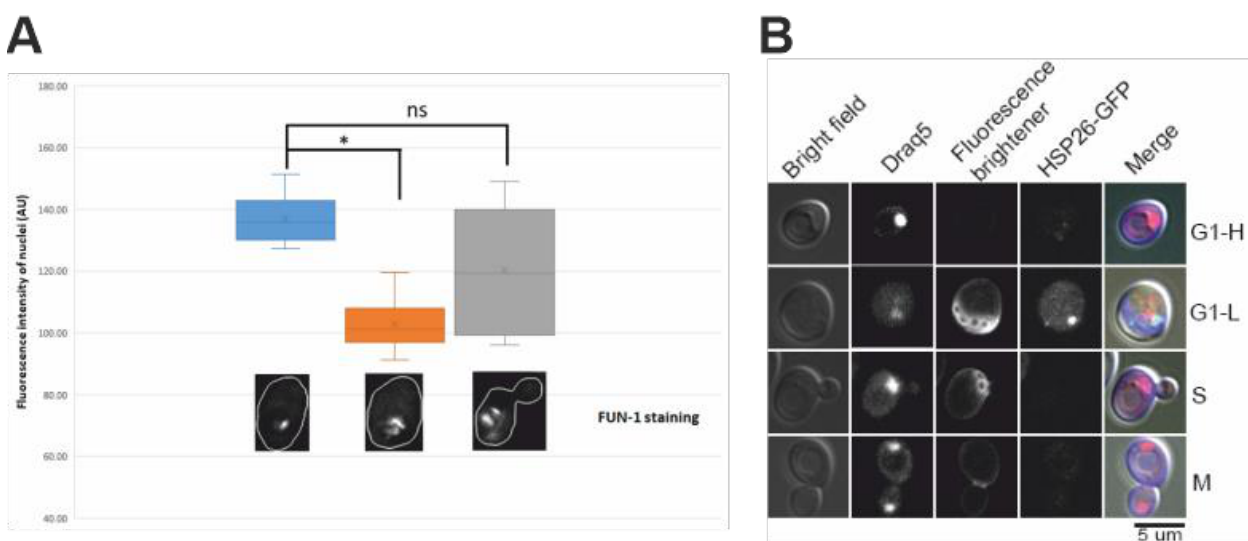
FIGURE 3. (A) Quantified DNA fluorescence intensity by DRAQ5 staining (top bar graph) in relation to metabolic level (FUN-1 staining, bottom) in log-phase cells without desiccation. It shows that G1 cells with higher DNA fluorescence intensity (by DRAQ5 staining) had a lower metabolic level (single crystal by FUN-1 staining) (left), while G1 cells with lower DNA fluorescence intensity had more than one FUN-1 crystals (middle), and S phase cells also had multiple FUN-1 crystals (right). Approximately 400 cells were counted from each experiment and the data presented here are the sum of three independent experiments. *: p < 0.05; ns: not significant. (B) HSP26-GFP localization in log-phase cells without desic- cation. Hsp26-GFP was observed in G1 cells with low DNA content (G1-L), but not in G1 cells with higher DNA content (G1-H), S-phase (S) or M- phase cells